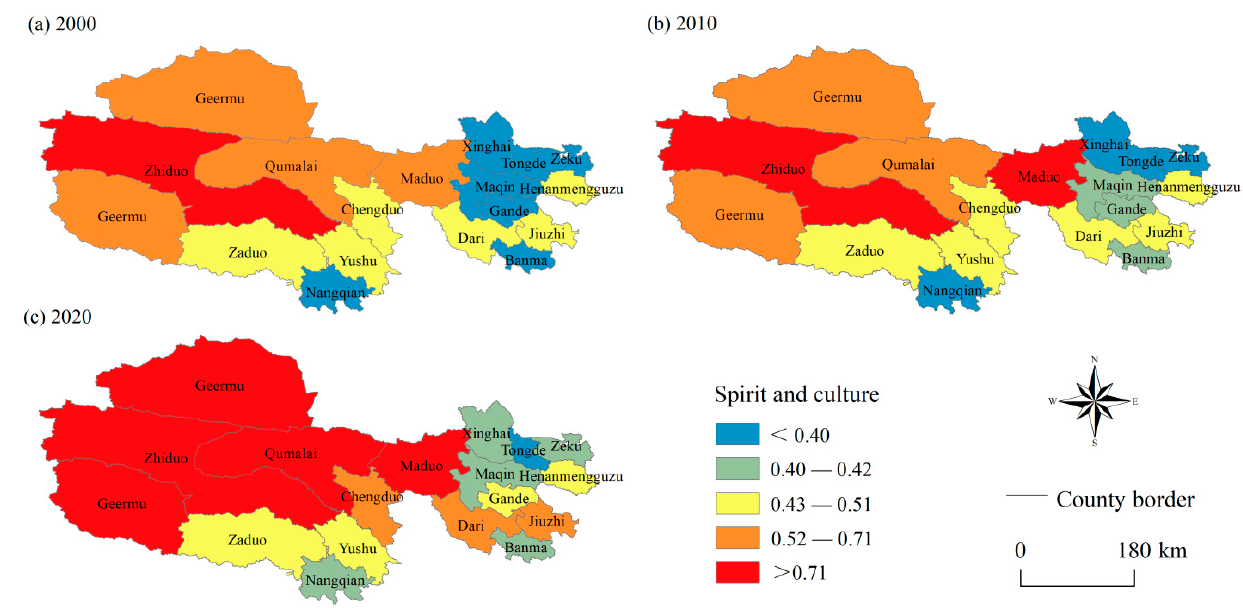
Figure 8. Spatiotemporal distribution of the spiritual and cultural index (SCI) in the Sanjiangyuan area during 2000–2020.